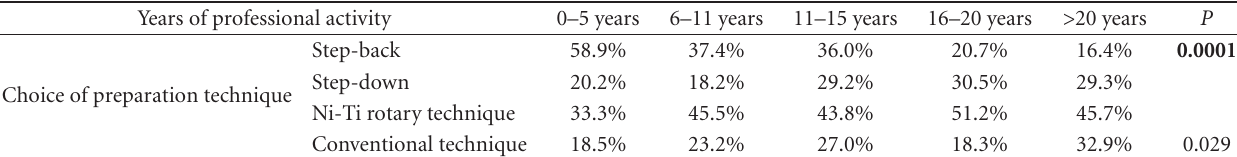
Table 3: Percentage of the choice of preparation technique and instrument, use of Ni-Ti rotary instrument according to years of professional experience.